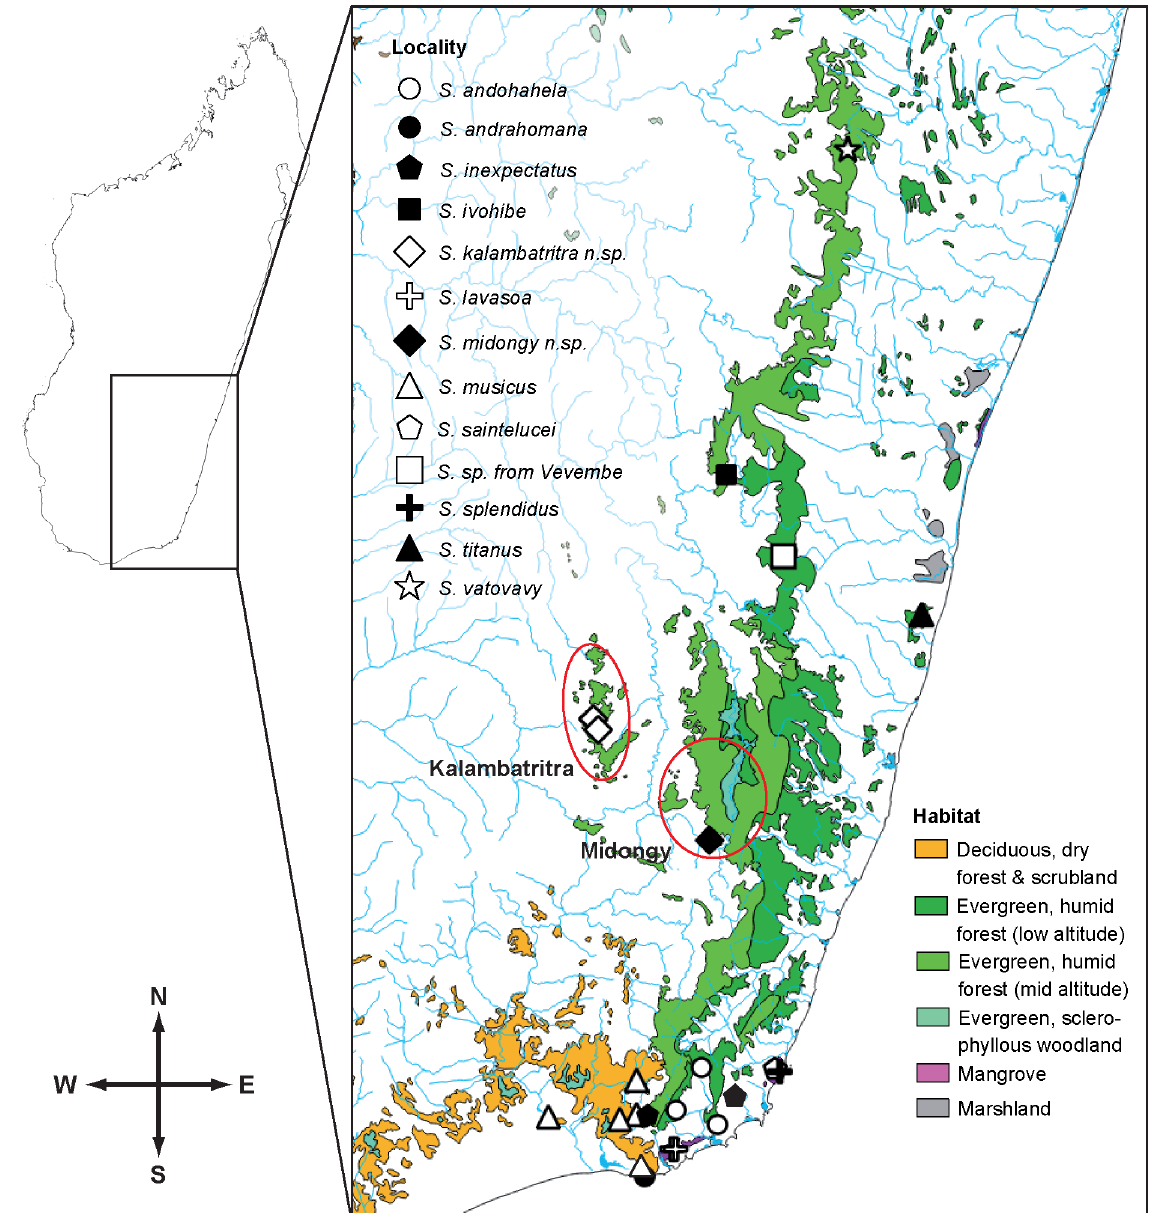
Fig. 11. Distribution of the genus Sphaeromimus de Saussure & Zehntner, 1902 in south-eastern Madagascar. Map modified after Moat & Smith